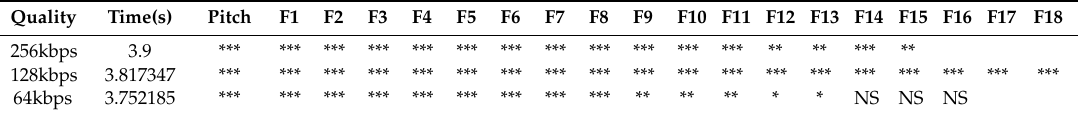
Table 6. The results of the confrontation considering the di ff erent qualities of audios (Sentence #1 for suspect #3).